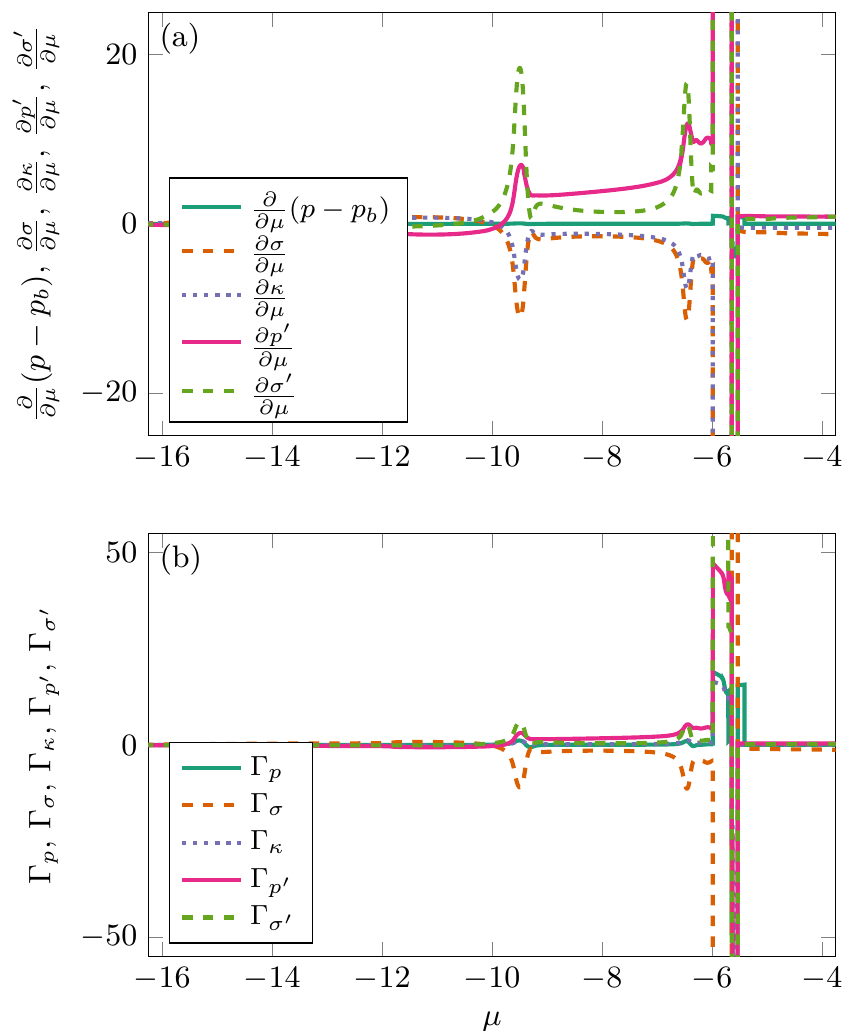
Figure 12. ( a ) Dimensionless Minkowski functional coefficients: the derivatives of pressure, ∂ ( p − p b ) / ∂µ , pressure per surface area, p (cid:48) ( µ , T ) , surface tension, ∂σ / ∂µ , bending rigidity, ∂κ / ∂µ , and the pseudo pressure and surface tension terms ∂ p (cid:48) / ∂µ and ∂σ (cid:48) / ∂µ , with respect to the chemical potential. These are the values of the coefficients that are used in Figure 11 to reconstruct the excess adsorption as a function of the chemical potential. ( b ) Contribution of the Minkowski functional coefficients to the excess adsorption for a pore with a radius of r p = 25 ( ≈ 9 nm) and an Euler characteristic of χ = −